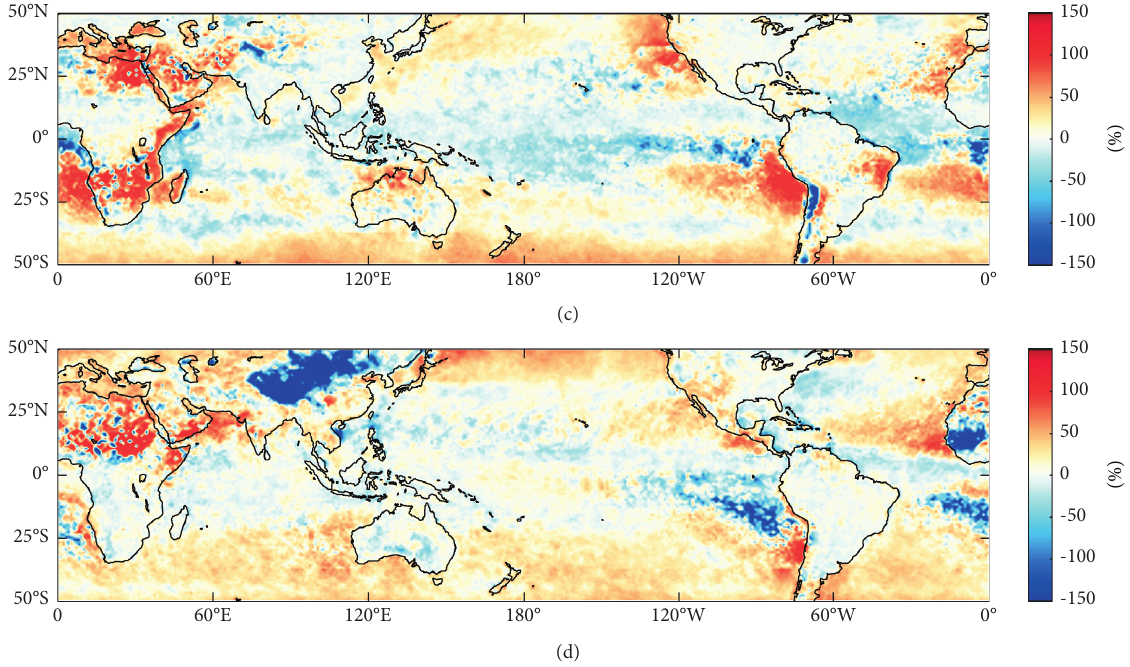
Figure 4: Relative differences (IMERG minus TMPA, relative to 5-year IMERG mean) between the IMERG V06B product and TMPA 3B42 product in (a) MAM; (b) JJA; (c) SON; and (d) DJF.